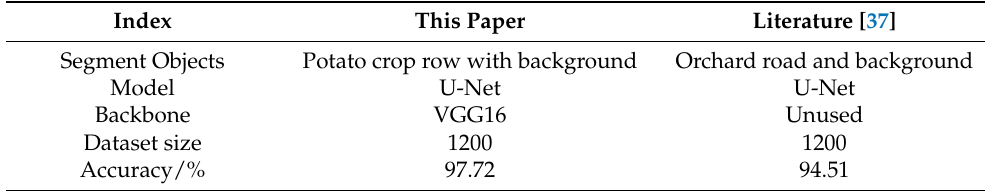
Table 4. Performance of U-Net on different segmented objects.